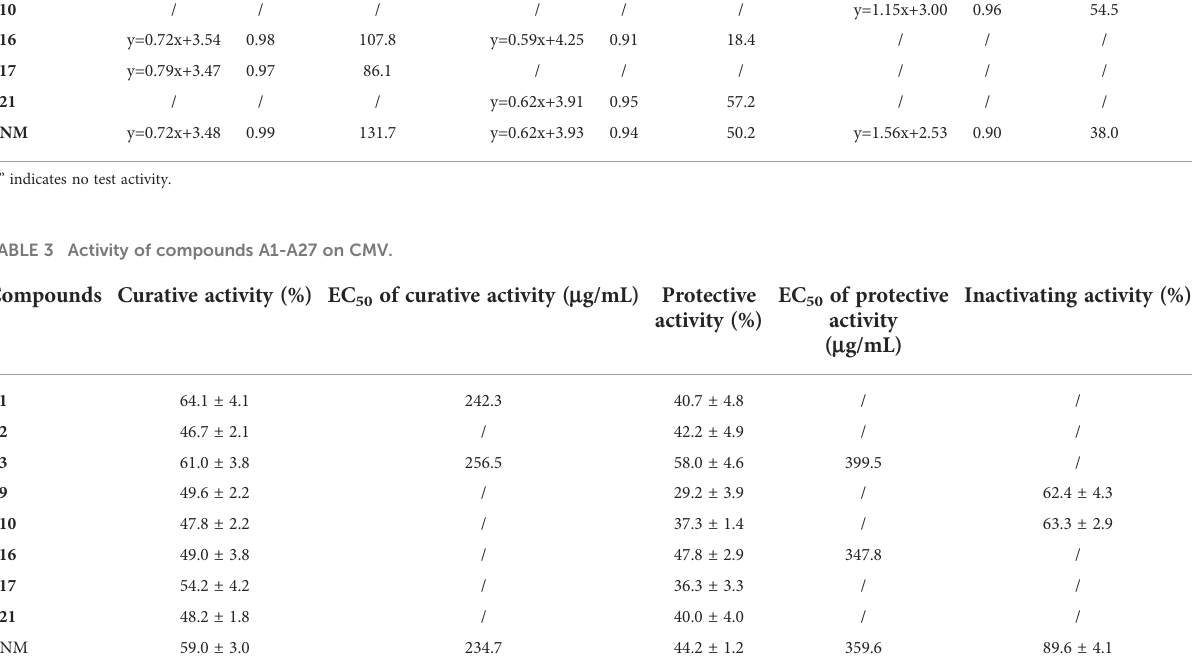
“ / ” indicates no test activity.